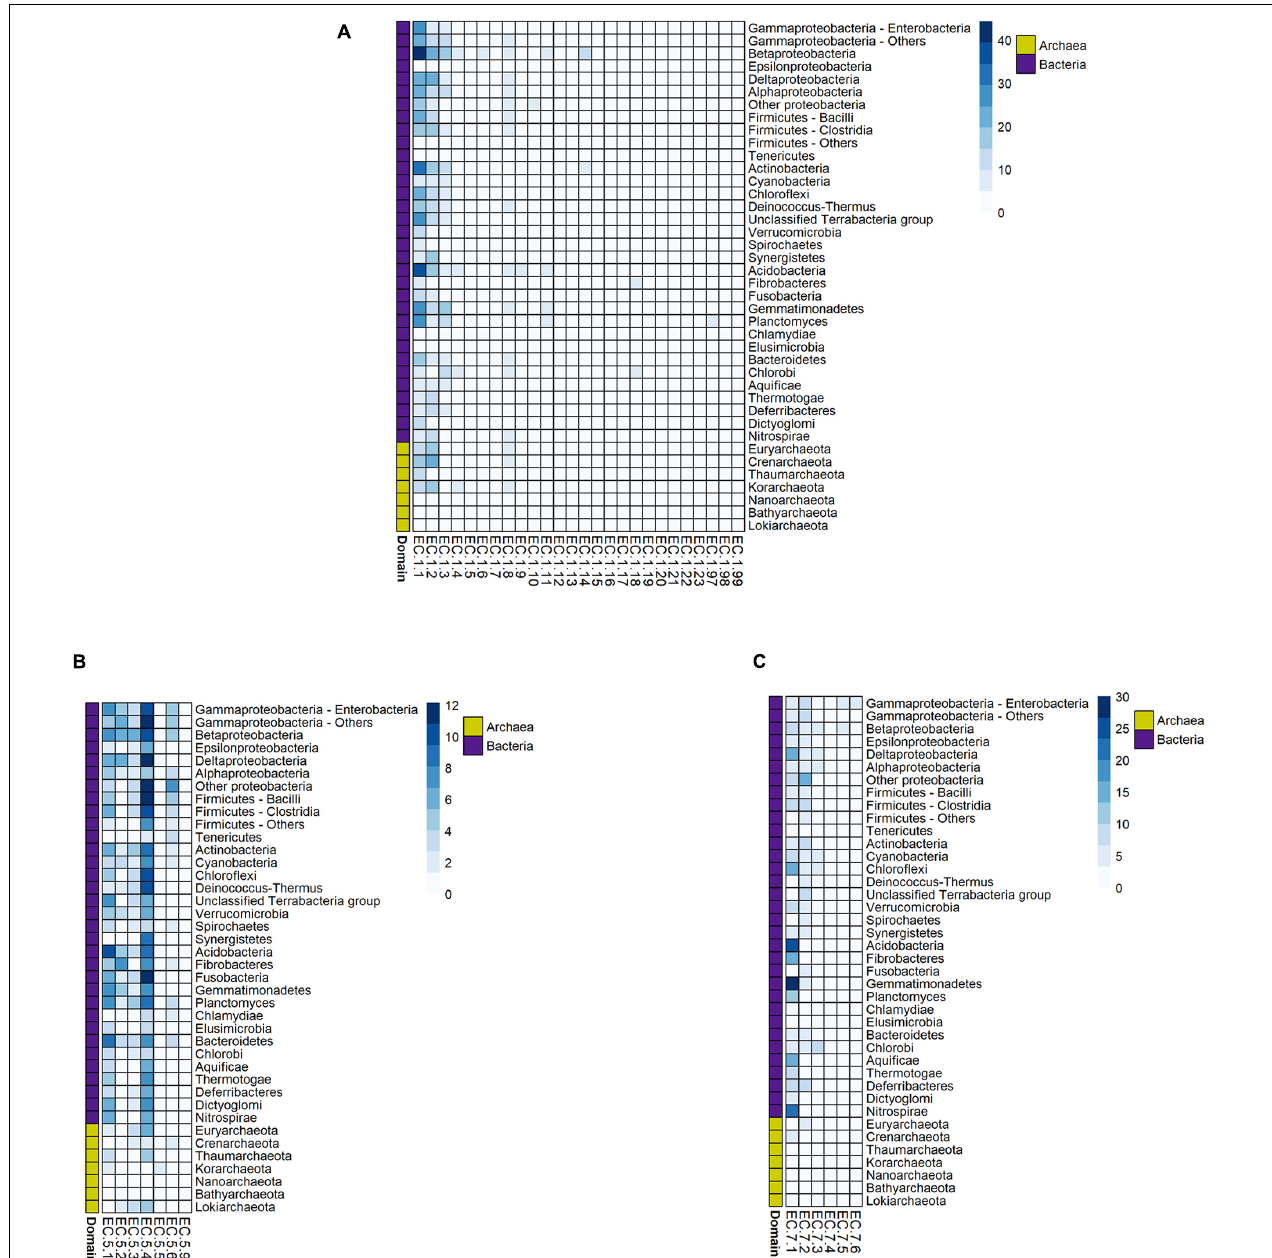
FIGURE 5 | Number of paralogous enzymes found within prokaryotic oxidoreductases (A) , isomerases (B) , and translocases (C) subclasses. Each cell in the heatmaps represents the mean value of the phylum for that specific